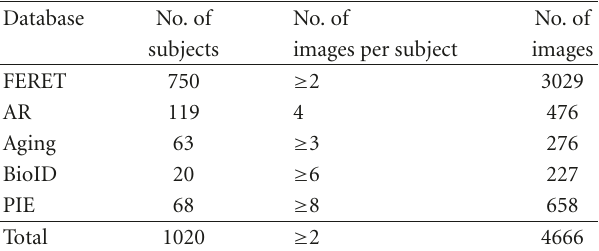
Table 3: Verification data set configuration. Database